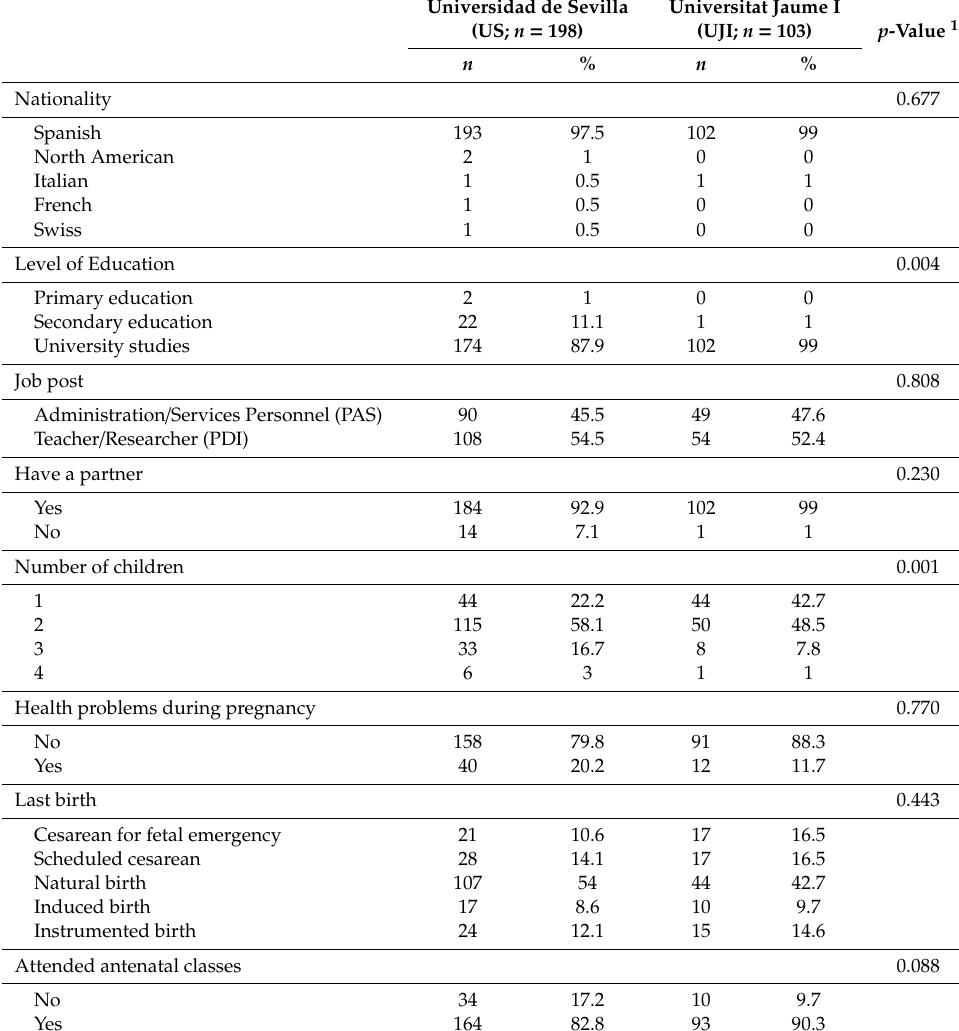
Table 1. Socio-demographic and gyneco-obstetric data of the female sample ( n =